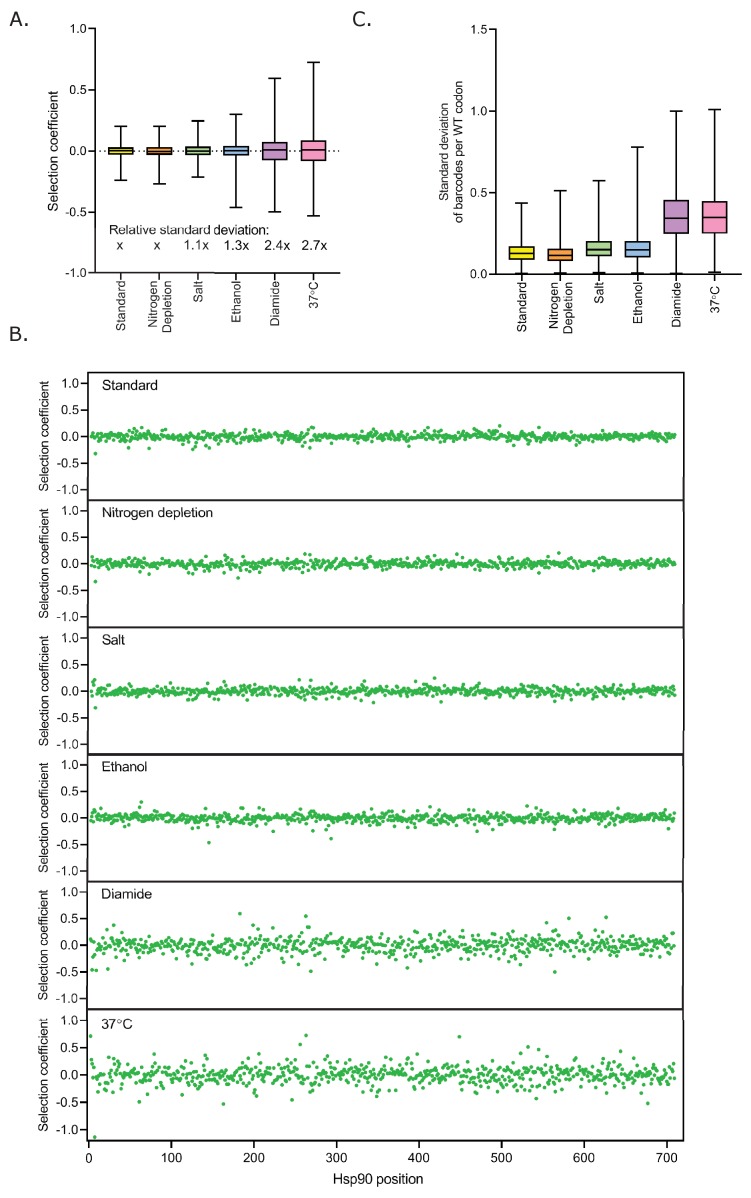
Analysis of variation in wild-type synonym selection coefficients.(A) Distribution of selection coefficients for the wild-type synonyms in each condition. The standard of deviation of wild-type synonyms in each condition relative to standard conditions (x) is specified under the corresponding box. (B) The selection coefficient for wild-type synonyms at each position of Hsp90 in each condition. (C) The variation of selection coefficients for barcodes with greater than 50 initial reads for each wild-type codon in each condition.